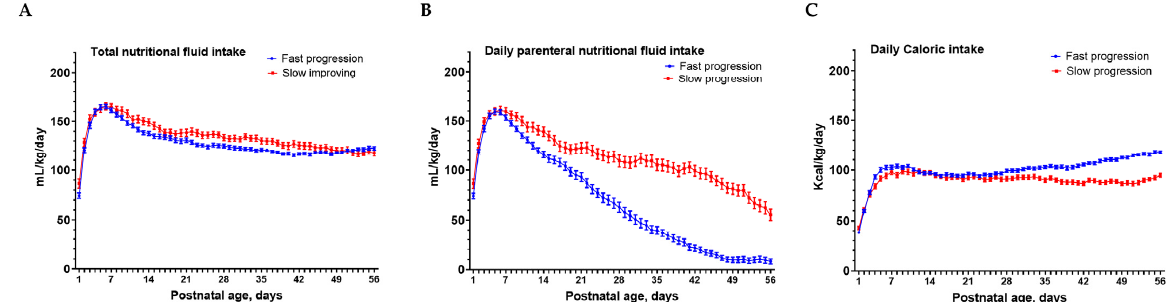
Figure 2. Differences of total nutritional fluid intake (mL/kg/day, ( A ), the daily parenteral nutritional fluid intake (mL/kg/day, ( B ), and total caloric intake (Kcal/kg/day, ( C ) in the first 56 postnatal days between the fast progression and slow progression enteral feeding progression groups. Data were presented as mean ± SEM. Bonferroni adjustment was used for the multiple comparisons between the two feeding groups at each time point. Significant statistical differences were observed in the parenteral nutritional fluid intake from day 13 to day 56; the total nutritional fluid intake on